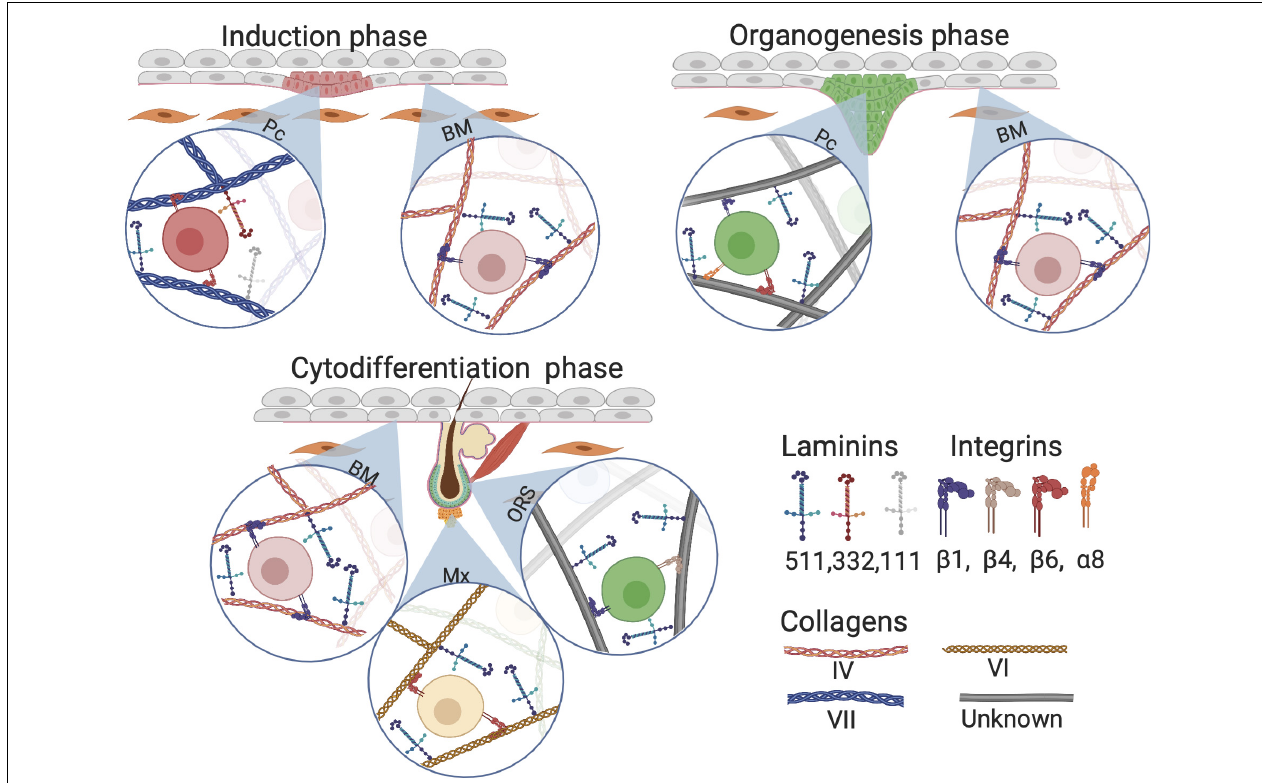
FIGURE 7 | Composition of extracellular matrix (ECM) proteins at different phases of HF development. Although Collagen VII anchors on collagen I fiber, we visualized collagen VII as a classical collagen fiber for simplicity. BM, basement membrane; Pc, hair follicle placode; Mx, hair matrix; ORS, outer root sheet.